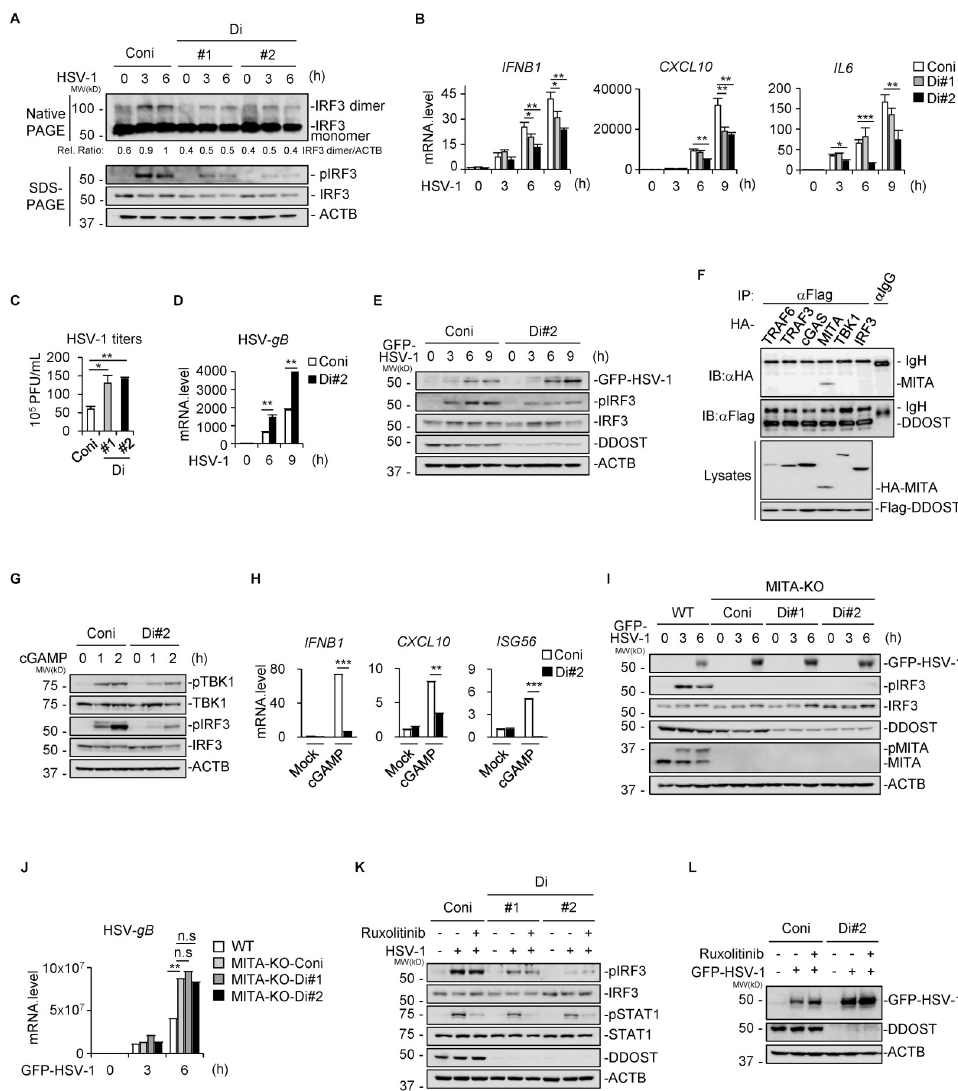
Fig 2. DDOST potentiates DNA-induced antiviral immune responses. (A) DDOST knockdown THP-1 cells and control cells were infected with HSV-1 (MOI = 2) for the indicated time before Native-PAGE (upper panel) and SDS– PAGE (bottom panels) analysis. The relative ratio (Rel. ratio) of the IRF3 dimer to ACTB was calculated by measuring the grayscale values of the bands and then normalized to the value at the time of the activation peak in the control group. One representative result from at least three independent experiments is shown. (B) DDOST knockdown THP-1 cells and control cells were infected with HSV-1 (MOI = 2) for the indicated time before qPCR analysis. The value from qPCR was first normalized with ACTIN and then divided by the normalized value of the control. Data displayed are the mean ± SD (n = 3). � P < 0.05, �� P < 0.01, ��� P < 0.001 (unpaired t test). (C) DDOST knockdown THP-1 cells and control cells were infected with HSV-1 (MOI = 1) for 24 hours before the plaque assays were performed. (D) Transcription of HSV- gB in transfected DDOST-knockdown and control cells was determined by qPCR. Data displayed are the mean ± SD (n = 3). �� P < 0.01 (unpaired t test). (E) DDOST knockdown THP-1 cells and control cells were infected with GFP-HSV-1 (MOI = 2) for the indicated time before immunoblotting analysis. One representative result from at least three independent experiments is shown. (F) HEK293T cells were transfected with Flag-DDOST and HA- tagged indicated molecules before Co-IP analysis was performed. IgH: immunoglobin heavy chain. (G, H) DDOST knockdown HaCaT cells and control cells were treated with 2’,3’-cGAMP (50 ng/mL) together with digitonin (10 μ g/ mL) for permeabilization for the indicated time, followed by immunoblotting (G) or qPCR (H). One representative result from at least three independent experiments is shown (G). Data displayed are the mean ± SD (n = 3). �� P < 0.01, ��� P < 0.001 (unpaired t test). (I, J) Stable MITA-deficient HaCaT cells (MITA-KO) were established by the CRISPR/ Cas9 technique. Endogenous DDOST in MITA-KO cells was then knocked down by lentiviral transduction (MITA-KO-Coni, MITA-KO-Di#1, MITA-KO-Di#2). These cell lines with control cells (WT) were infected